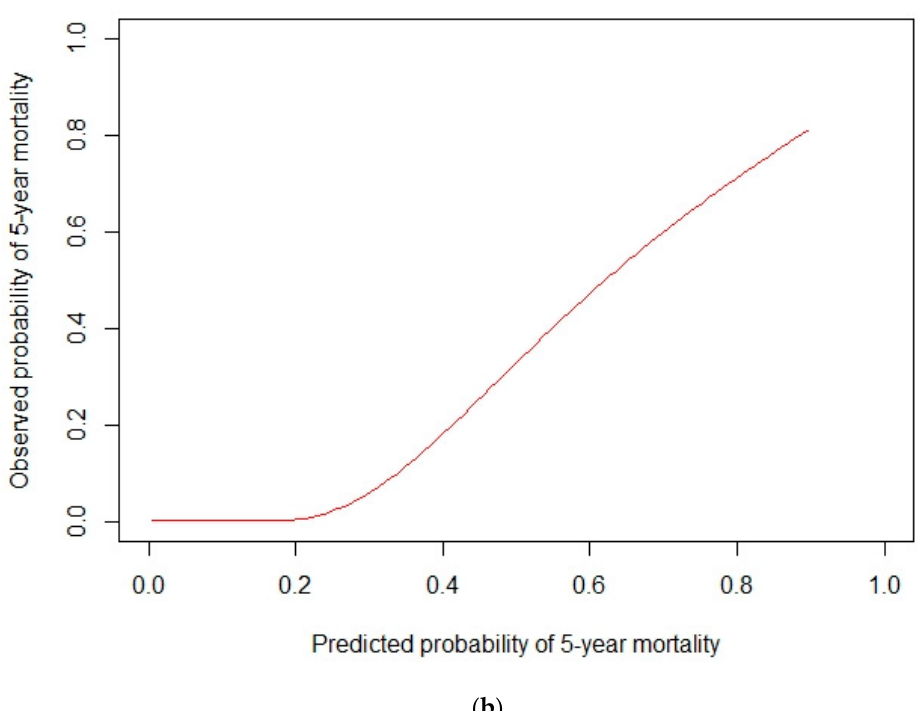
Figure 3. Calibration curves of the prognostic model. Plot demonstrates concordance between the predicted and observed survival in the validation cohorts at ( a ) 3 and ( b ) 5 years.